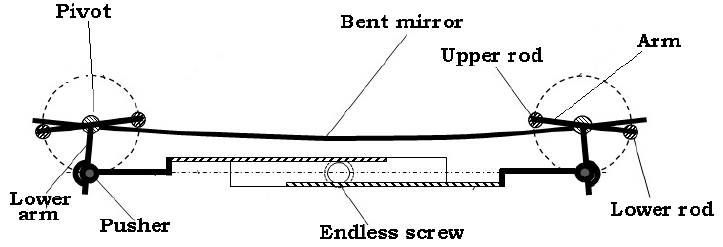
Figure 5. Cross-section of a mirror bent by means of torque applied to both lateral sides.